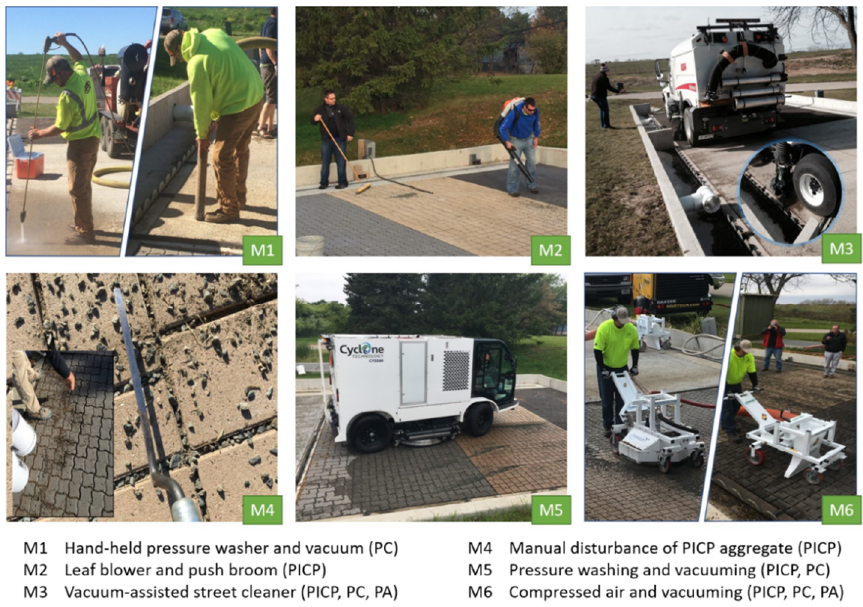
Figure 5. Images of the six different maintenance practices that were evaluated for use on permeable interlocking pavers (PICP), pervious concrete (PC), and porous asphalt (PA) test plots.